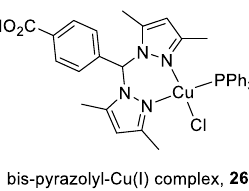
Figure 4. Structure of Cu(I) complex as a Top1/2 α dual inhibitor.